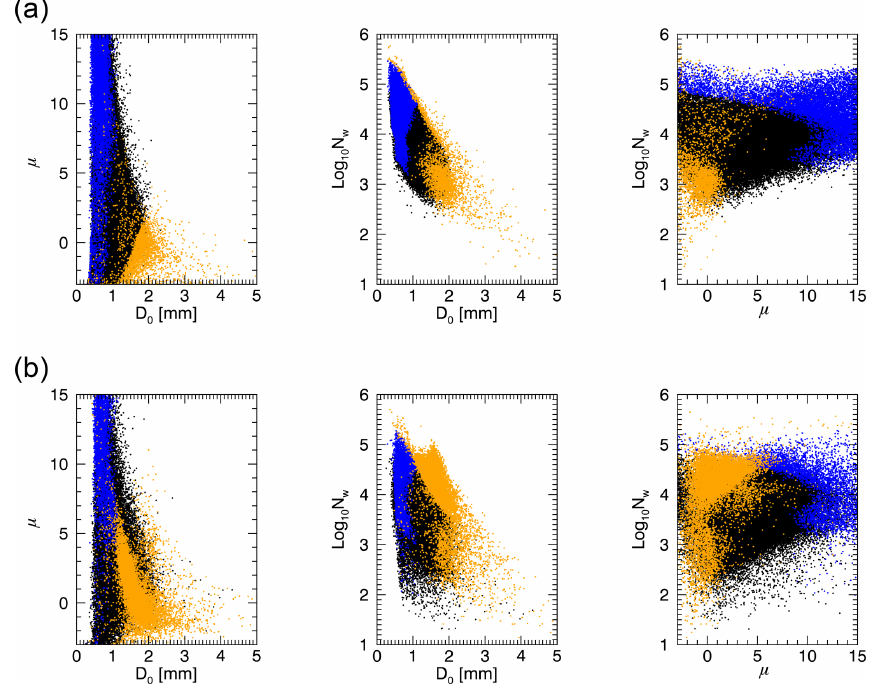
Figure 3. Disdrometer data from extratropical (a) and tropical (b) ocean sites. Blue and orange points were determined, via PC analysis, to be analogous to stratiform and convective DSDs, respectively, whereas black points did not fall into those